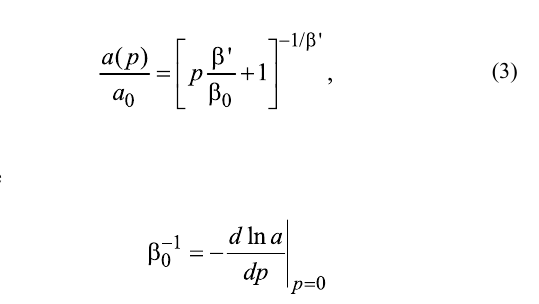
Figure 2: Pressure-dependent G and 2D peak position shifts for graphene on various substrates, as well as bilayer and nitrogen-doped graphene. Symbols show the experimental points, and solid lines represent general trends of peak shift.